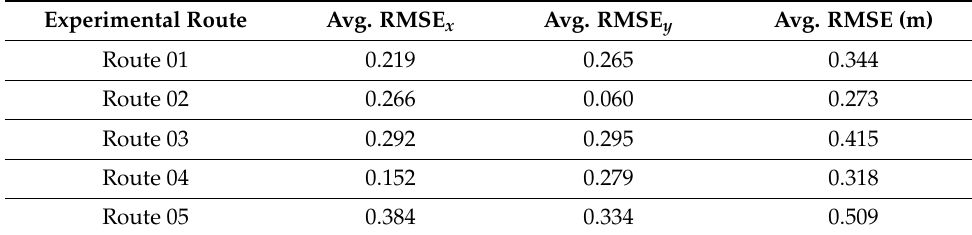
Table 5. TBM: The average RMSE of Routes 01~05.